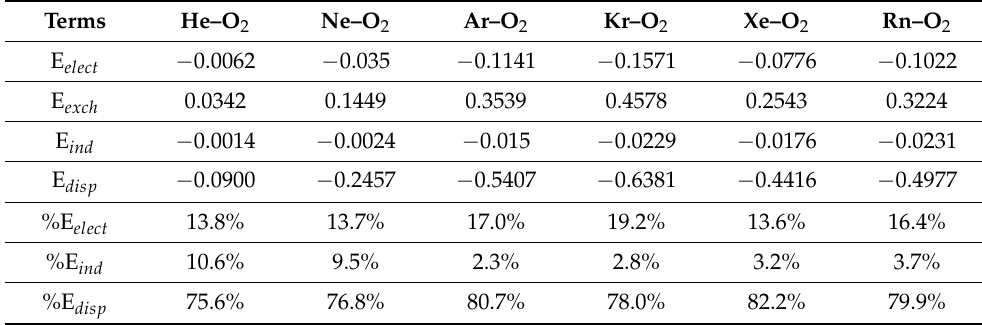
Table 6. Interaction energy decomposition (given in Kcal/mol) of the Ng–O 2 complexes calculated at the sapt2+3(CCD)/aug-cc-pVTZ level.